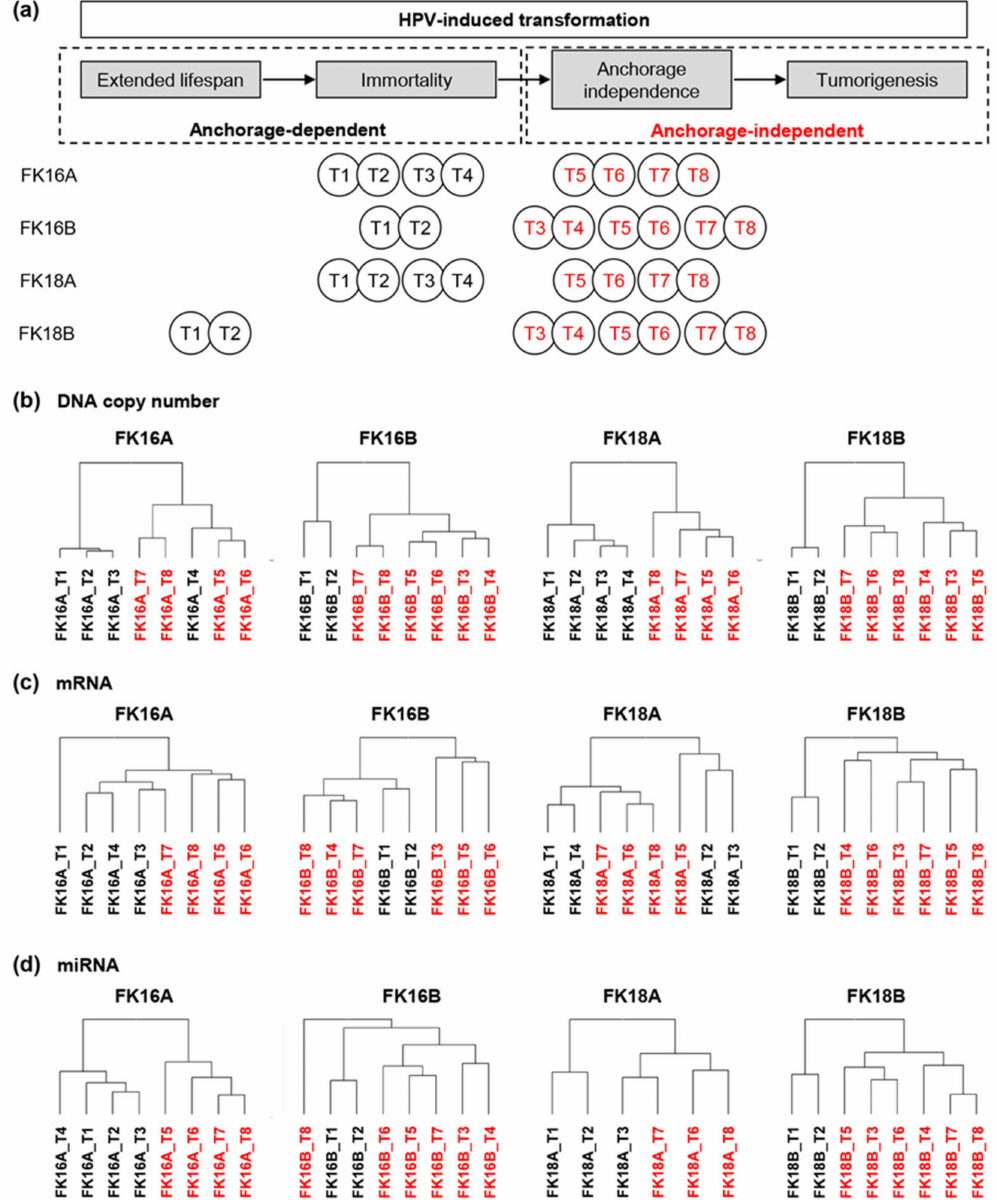
Figure 1. Characterization of our longitudinal in vitro model system of human papillomavirus (HPV)-induced transformation. ( a ) Anchorage-dependent (black) and -independent (red) time points (T) of all four cell lines are shown in relation to the transformation process [16]. MiRNA microarrays of cell line FK18A at T4 and T5 did not pass quality control and were therefore excluded from miRNA analysis. Unsupervised hierarchical cluster results based on ( b ) DNA copy number, ( c ) overall mRNA expression, and ( d ) overall miRNA [16] expression are shown for FK16A, FK16B, FK18A, and